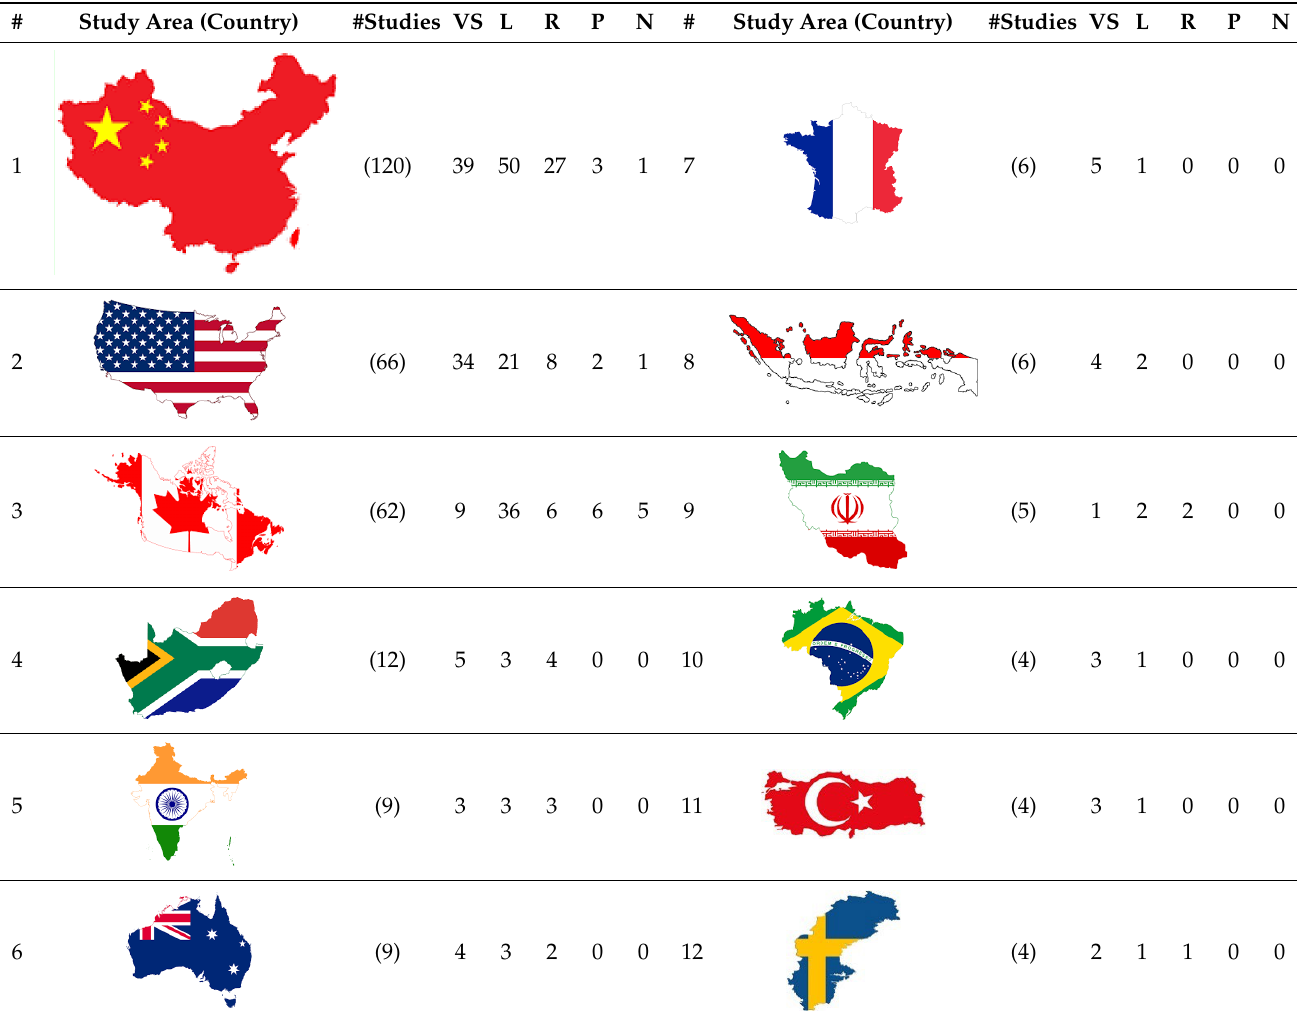
Table 4. Overview of study site locations grouped by countries coupled with various scales of the study site’s extent. Sites with four or more studies were included.